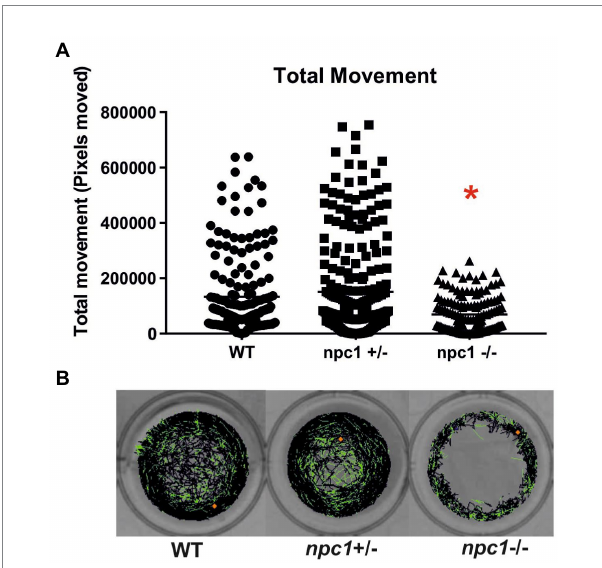
FIGURE 8 (A) npc1 − / − larvae have significant reduction in locomotion compared to npc1 +/ − and wt larvae at 3 wpf value of p = 0.0002. (B) Example of locomotion tracks are shown. The orange dot indicated the start position of the larvae. Green color indicated slow movements and black color regular movement. Statistically significant data in the graphs is indicated with a red *.